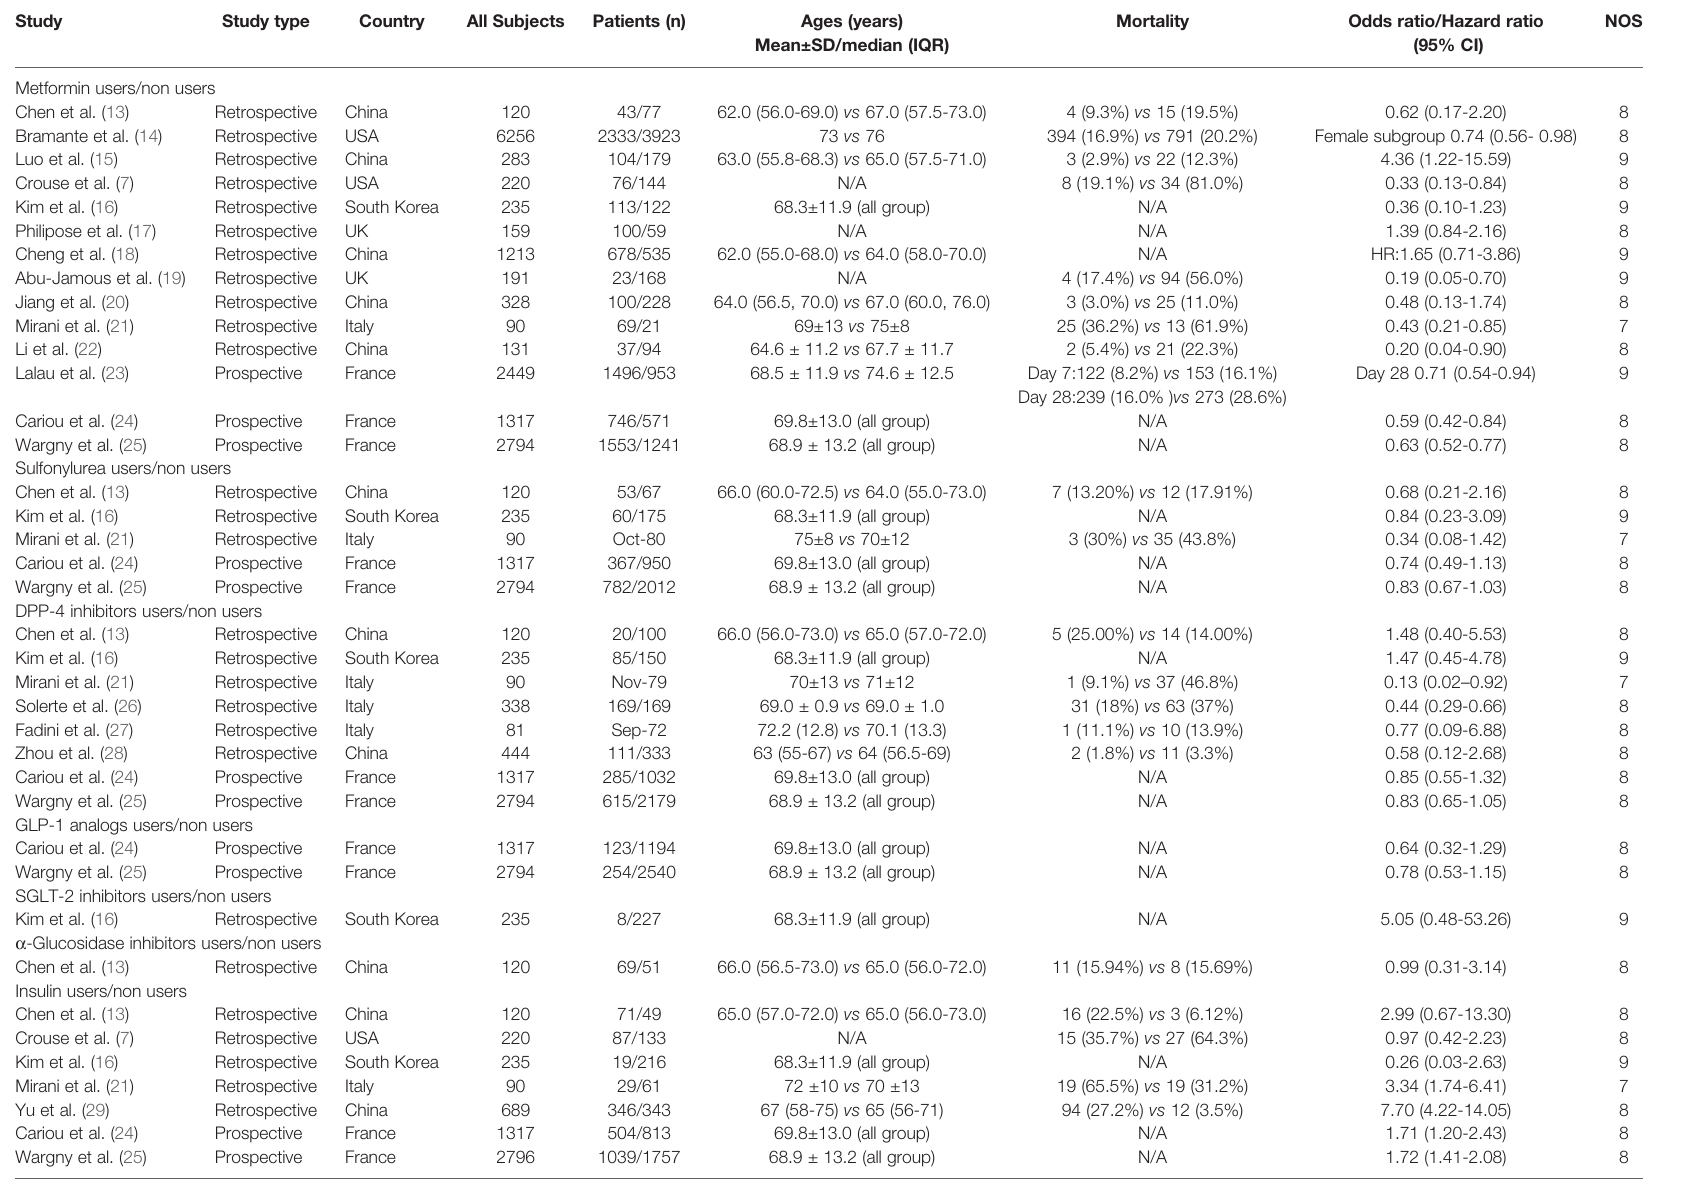
TABLE 1 | The characteristics of the included studies in meta-analysis. Study